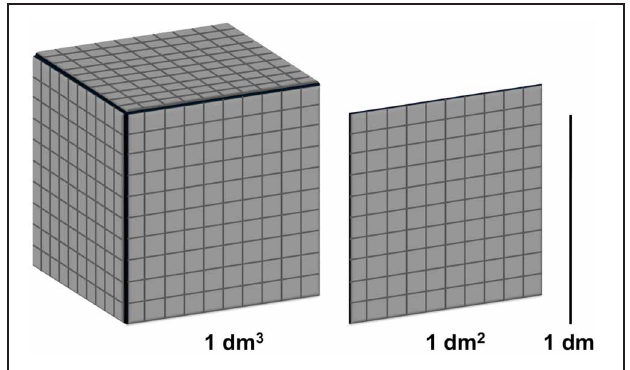
FIGURE 1 | Depicts the rescaling relationships of a cube, surface, and a line that determine a regular object’s Euclidean dimension.